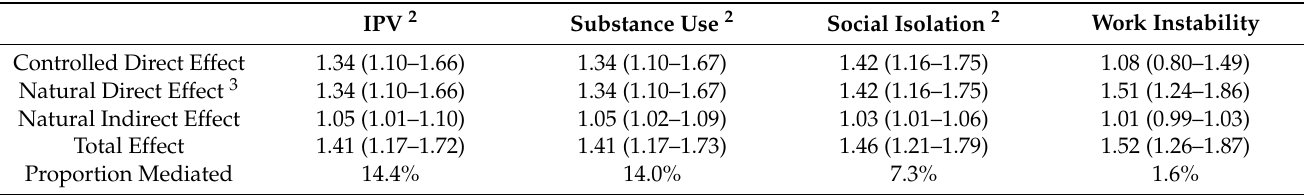
Table 2. Adjusted risk ratios 1 for direct and indirect effects and proportion